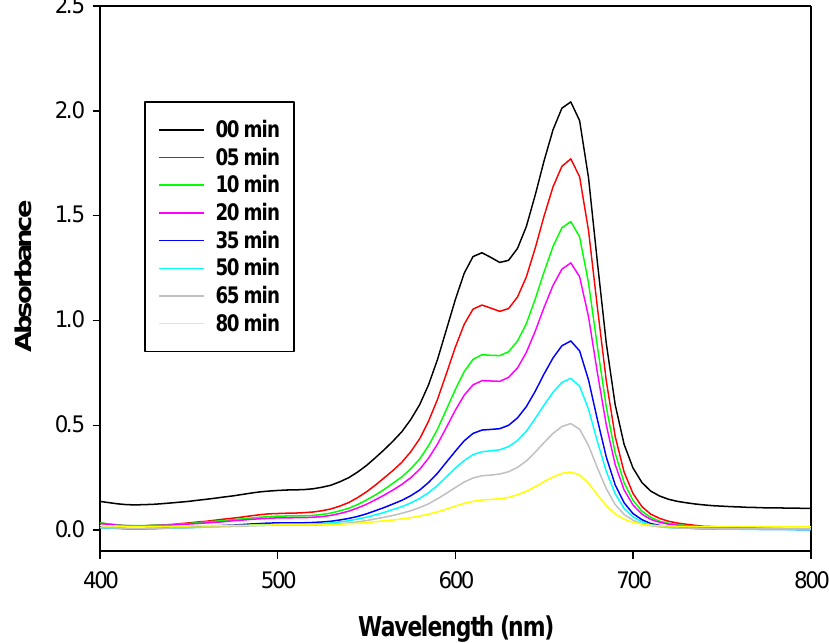
Figure 8. An absorption spectra for methylene blue decolorization in the presence of ZnO-GO.